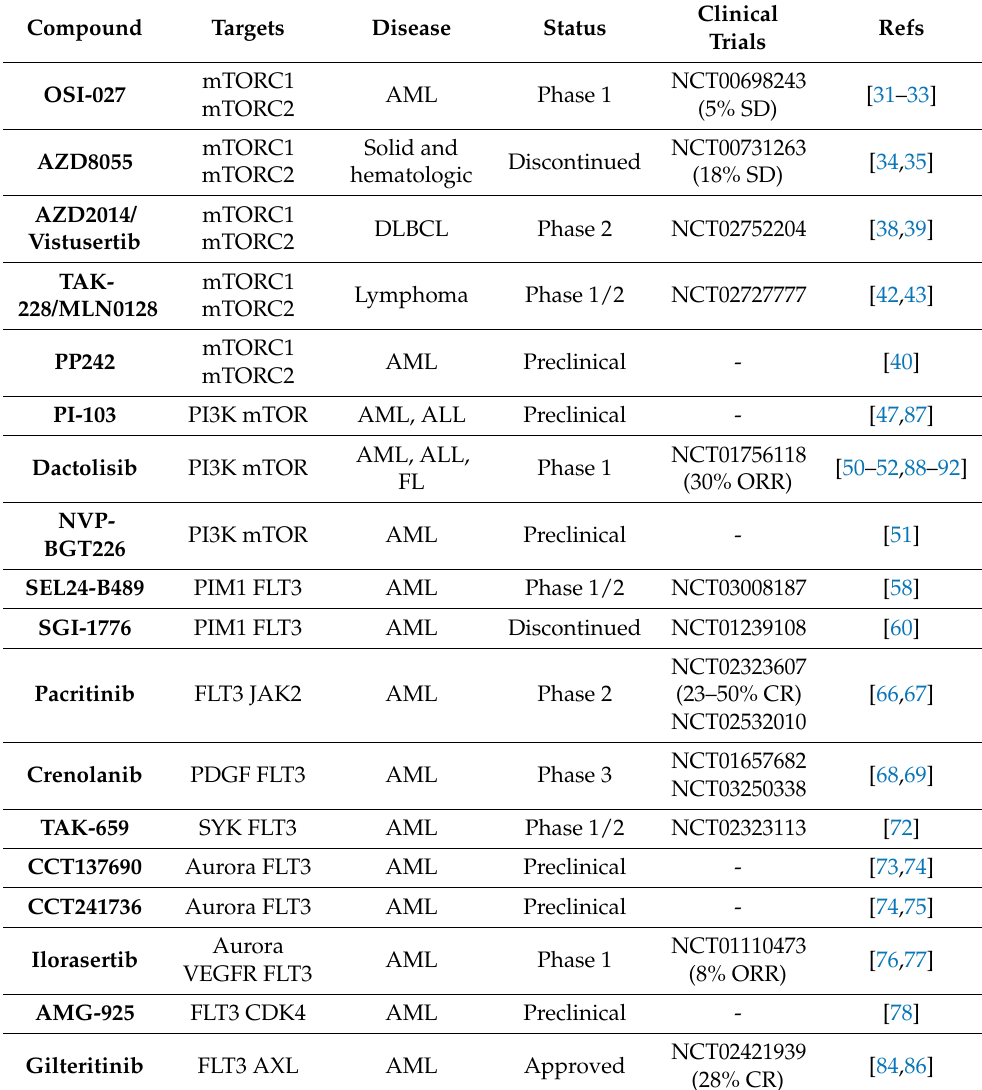
Table 1. Molecular targets and clinical studies of dual agents proposed for the treatment of acute myeloid leukemia